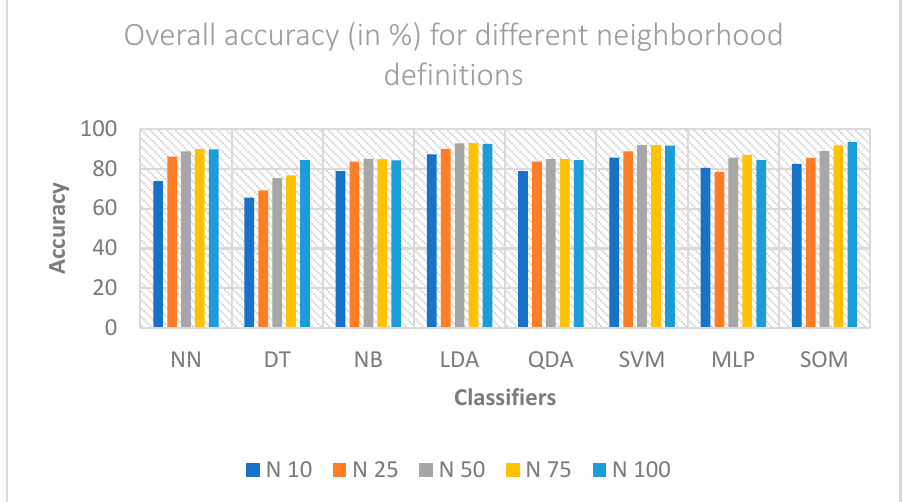
Figure 13. Neighborhood definitions for various classifiers. Precision is the level of a classifier’s conformance and accuracy when measured against a real or absolute value. The accuracy levels of different classifiers for various neighborhood configurations are compared in Figure 14. Comparing the SOM approach to others, we find it to be very accurate.